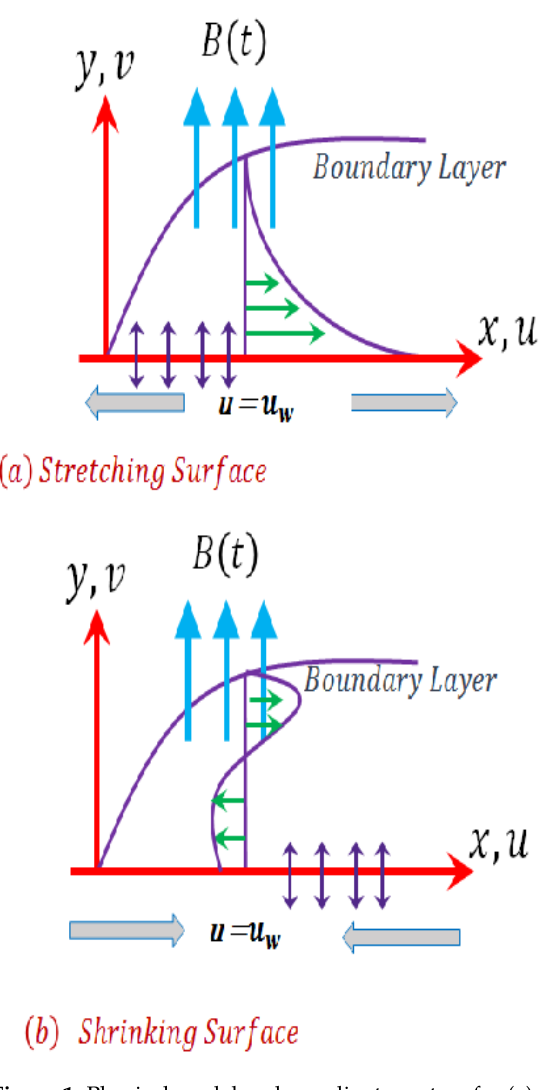
Figure 1. Physical model and coordinate system for ( a ) stretching case and ( b ) shrinking case.